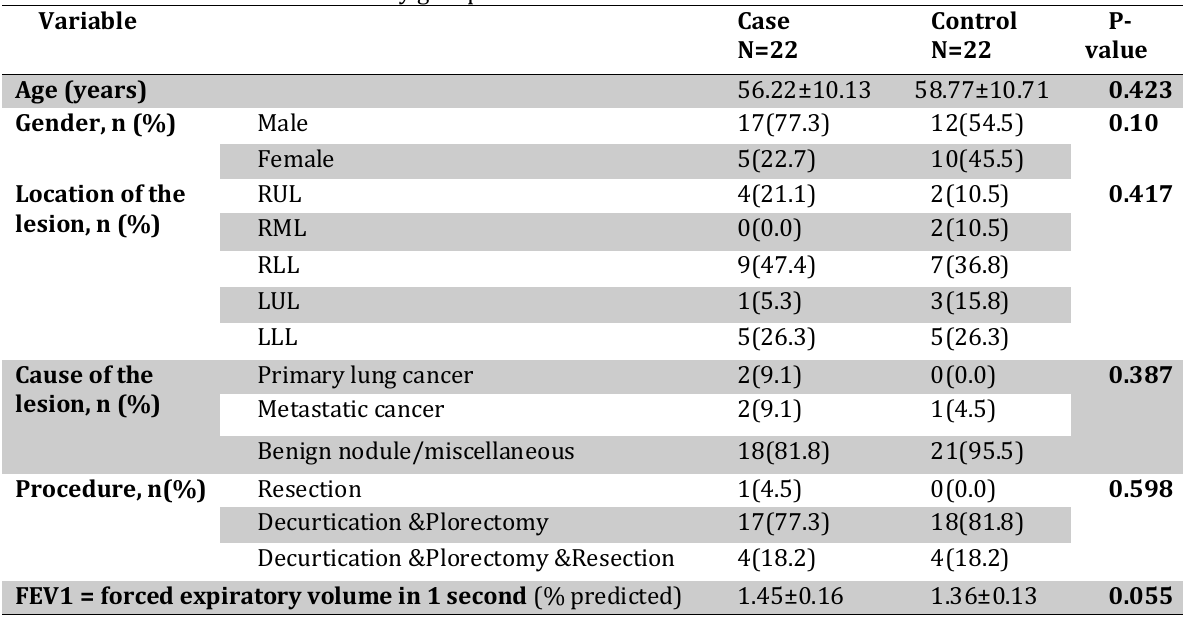
Table 2: Clinical features in 2 study